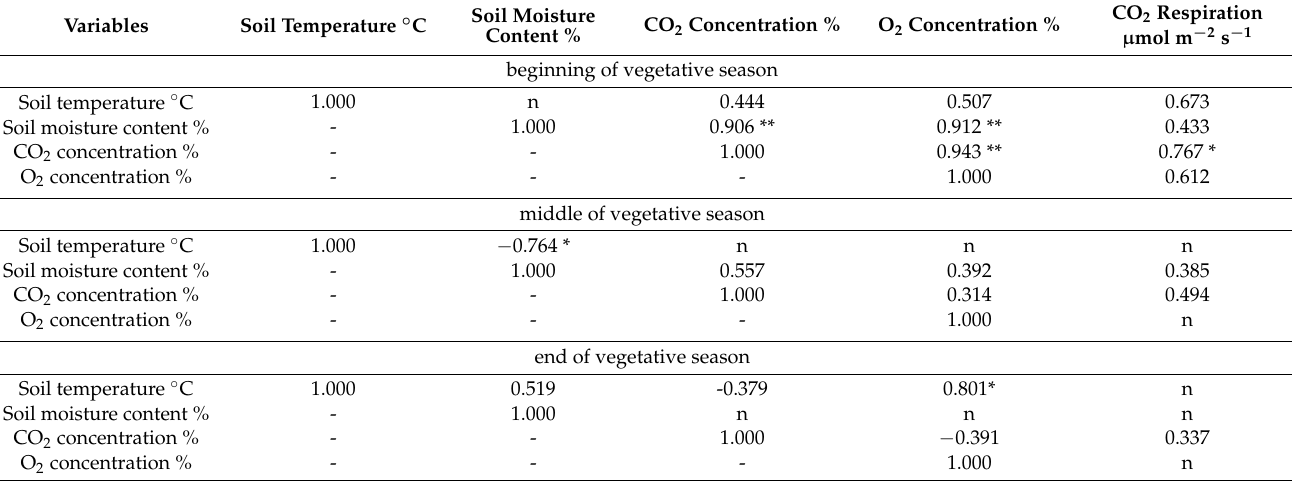
Table 7. Correlations between soil hydrothermal conditions and gas disposition,